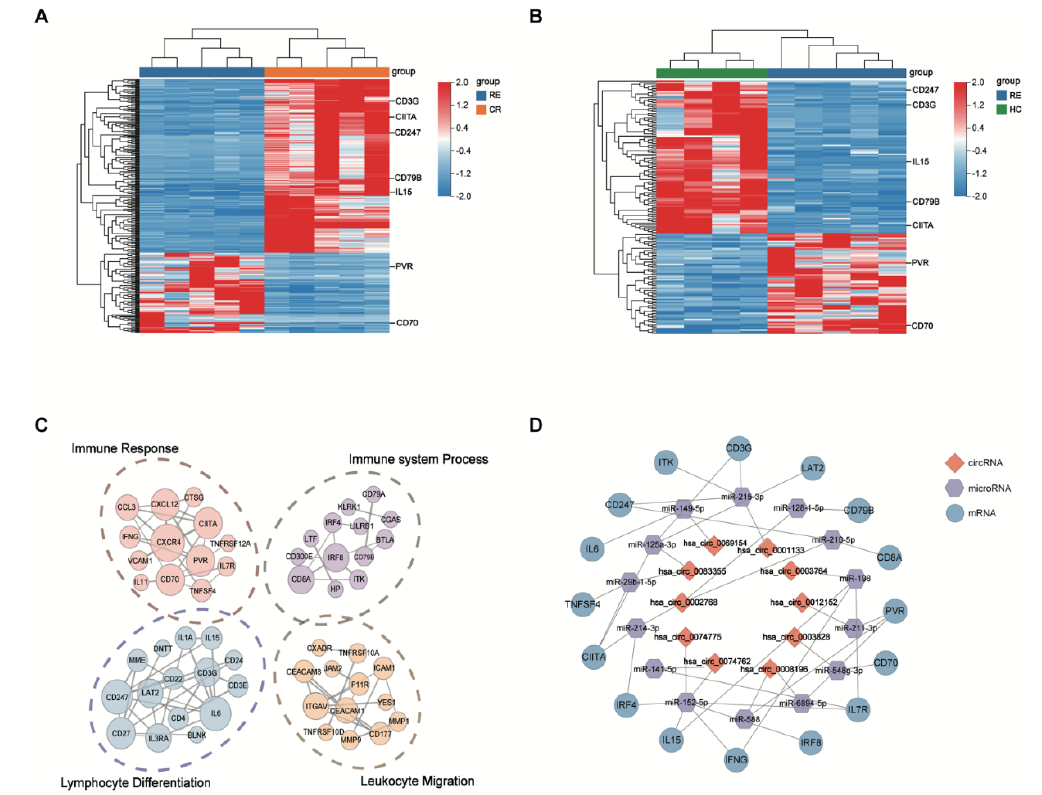
Figure 6. The DE circRNAs identified in relapse blasts regulate immune-related mRNAs. ( A , B ) Heatmaps show that immune-related DE mRNAs co-expressed with DE circRNAs from unsupervised hierarchical clustering present in AML patients with relapse versus remission ( A ) and relapse versus healthy controls. ( B , C ) Protein–protein interaction analysis shows the significantly altered expression pattern in the immune-related genes regulated by DE circRNAs in relapse blasts. Edges indicate scores based on the STRING database, and node size indicates shared genes. ( D ) The construction of a circRNA–miRNA–mRNA ceRNA network based on the selected hub genes related to immune regulation. The ceRNA regulatory network includes 16 mRNAs, 14 miRNAs and 10 circRNAs. The red square nodes represent circRNAs, the purple hexagonal nodes indicate miRNAs and the blue circular nodes denote mRNAs. Table 2. The top 20 hub genes identified by cytoHubba. Gene Symbol MCC log 2